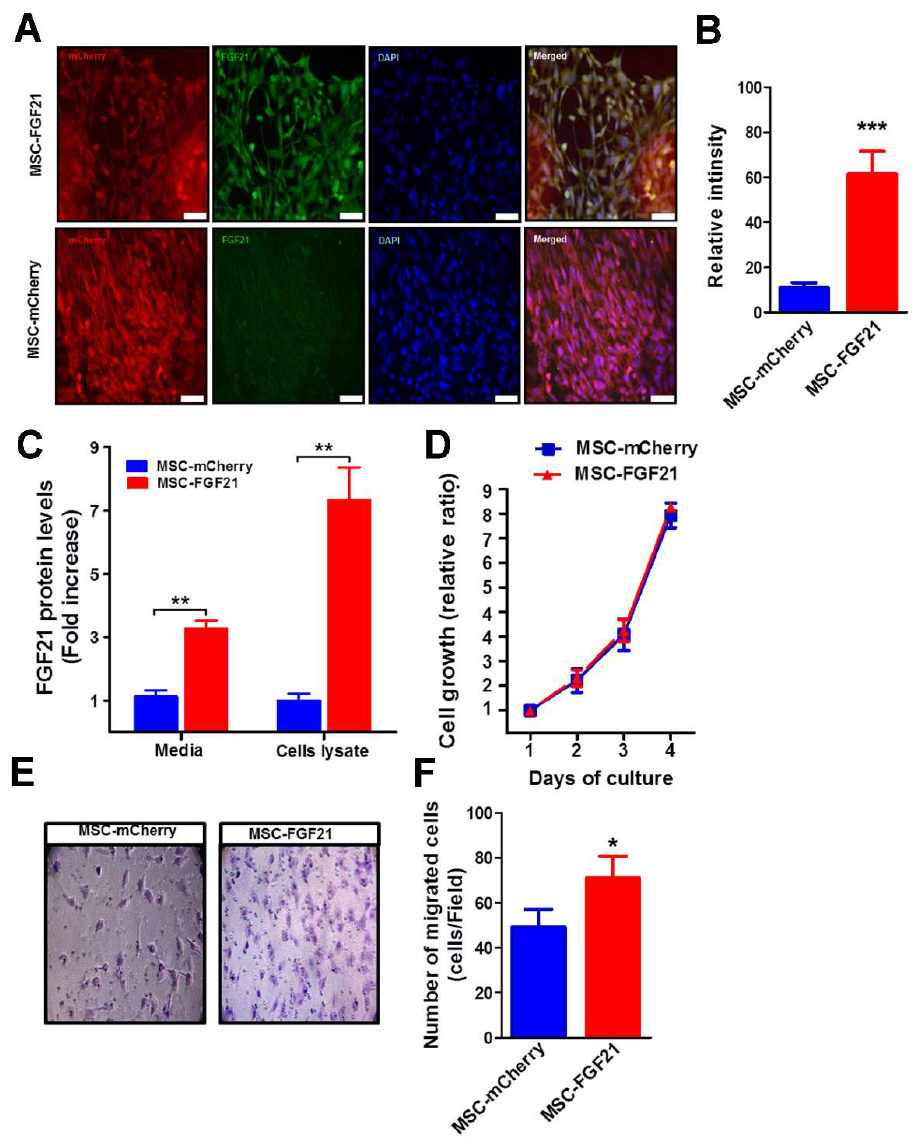
Figure 1. Characterization and in vitro migratory e ff ects of Mesenchymal stem cells (MSCs) that overexpressing Fibroblast Growth Factor 21 (FGF21) and mCherry protein